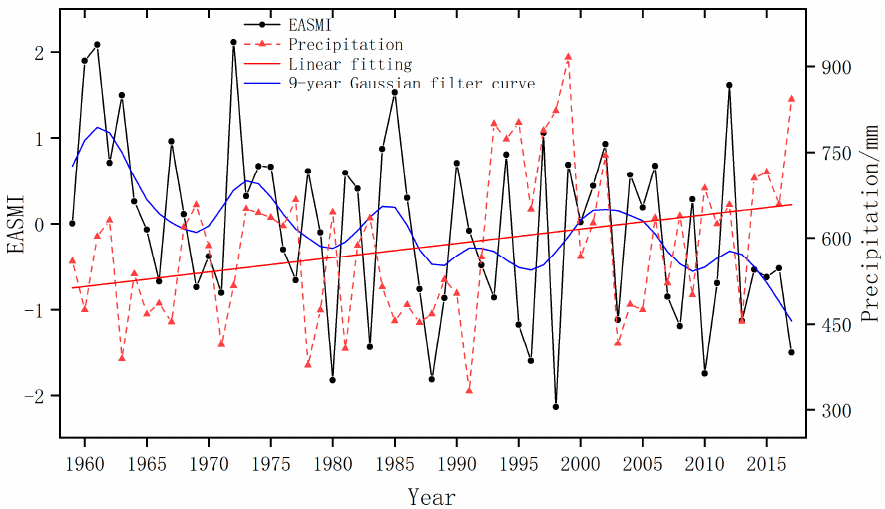
Figure 7. The solid black line indicates the normalized time series of the EASMI for the period of 1959–2017. The solid blue line indicates 9-year Gaussian-type filtered values of the EASMI. The dashed red line represents the average summer precipitation in the PYLB during 1959–2017. The solid red line represents its trend.